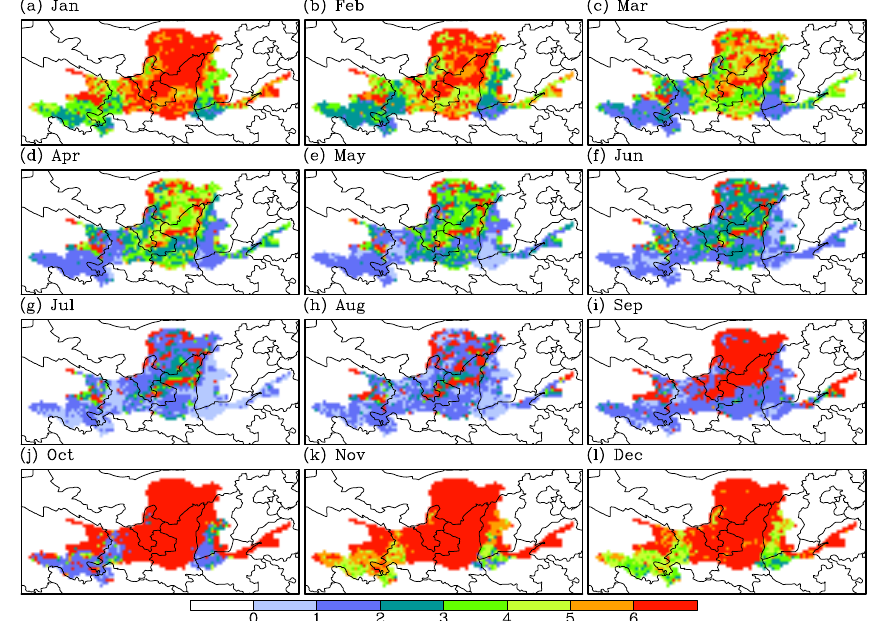
Figure 9. The same as Fig. 8 but for soil